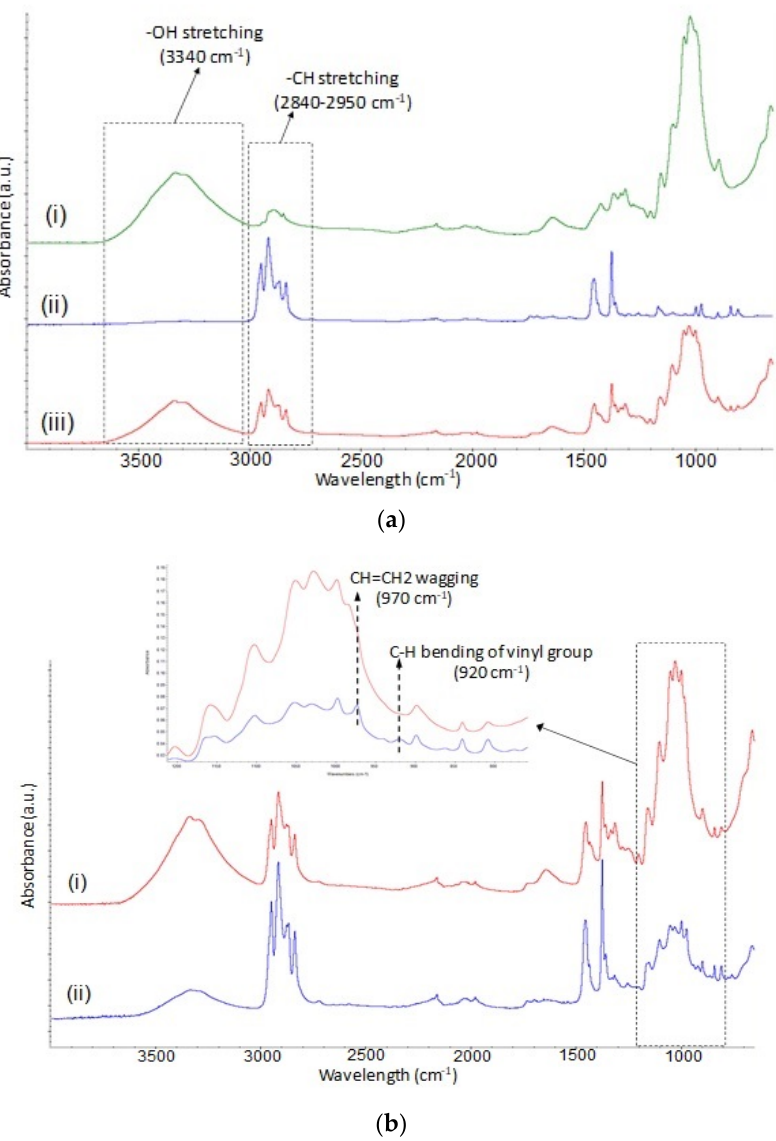
Figure 3. IR spectra of ( a ) (i) flax fibres, (ii) PP fibres and (iii) commingled Flax/PP woven fabric;